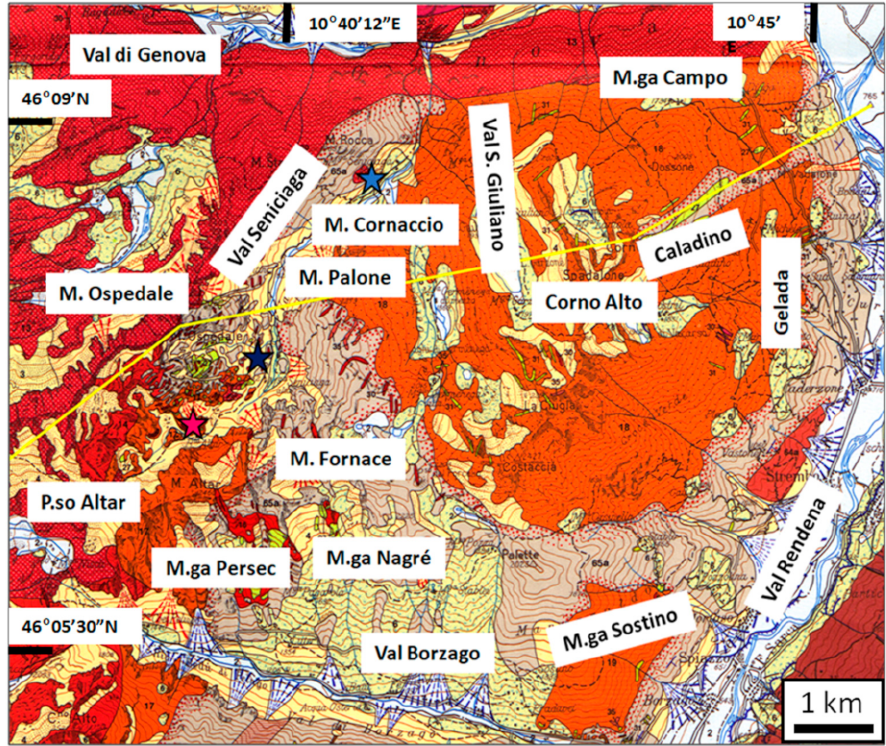
Figure 3. Detailed view of the Corno Alto-M. Ospedale area (framed in Figure 2a), after [29]. Profile trace is in yellow; blue star (Malga Seniciaga bassa, MSB, Table 1), violet star (Malga Seniciaga alta) pink star (Baito